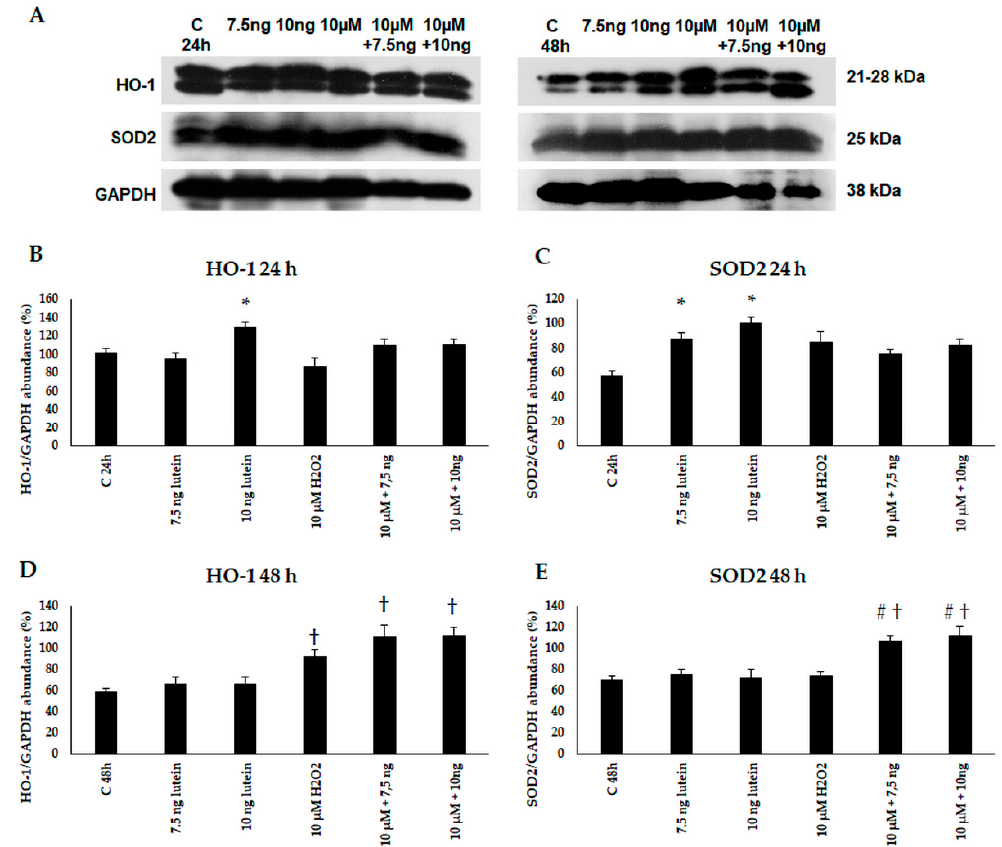
Figure 5. ( A ) Western blot analyses of antioxidant proteins HO-1 and SOD2 in lutein and in H 2 O 2 -treated BV-2 cells at 24 and 48 h. GAPDH was used as loading control. ( B – E ) Optical density analyses of HO-1 and SOD2 in BV-2 cells at 24 and 48 h. The columns represent mean values and error bars represent standard deviation (SD) of three independent determinations ( n = 3). * indicates statistical significance of lutein treatments versus controls; † indicates statistical significance of H 2 O 2 -treated cells compared to controls; # indicates statistical significance of combined (lutein with H 2 O 2 ) treatments compared to H 2 O 2 treatments; the level of significance was p < 0.05. Abbreviations: C marks the appropriate absolute controls at 24 and 48 h; 7.5 ng means 7.5 ng/ µ L of lutein; 10 ng means 10 ng/ µ L of lutein; 10 µ M refers to 10 µ M H 2 O 2